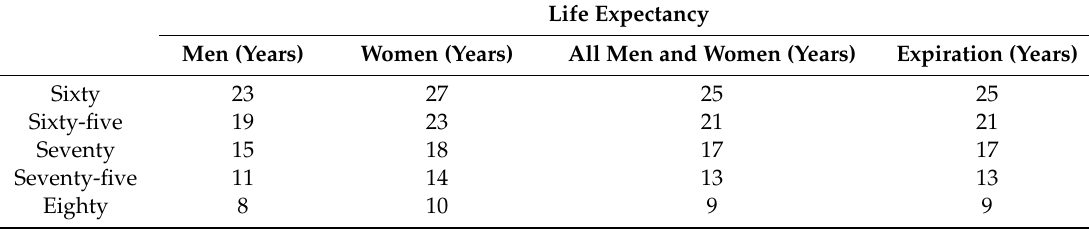
Table 1. Life expectancy in South Korea. This table presents the life expectancy of South Koreans by age and gender group in 2017. The Korean’s life expectancy estimates are given by Statistics Korea every year. Life Expectancy Men (Years) Women (Years) All Men and Women (Years) Expiration